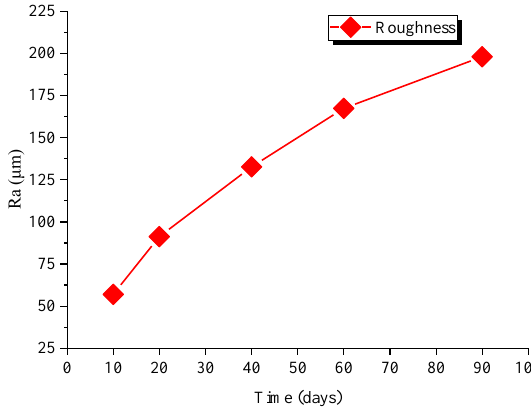
Figure 12. The relationship between roughness and time.